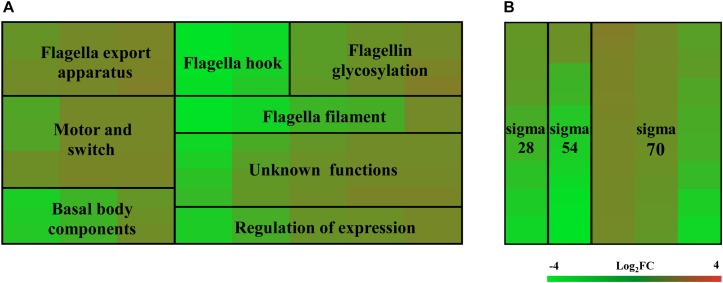
Heat map of relative mRNA expression of C. jejuni flagella genes. The transcription of flagella genes in the RNA-Seq were analyzed according to their function and substructure affiliation (A), as well as transcription cascade (B). Flagella hook genes and class II genes were significantly affected according to the ANOVA analysis at P < 0.05. Green and red in the heat map represent down-regulation and up-regulation of genes in the flhF mutant relative to the wild-type strain, with more saturated colors representing a larger differential effect as listed in the bar.